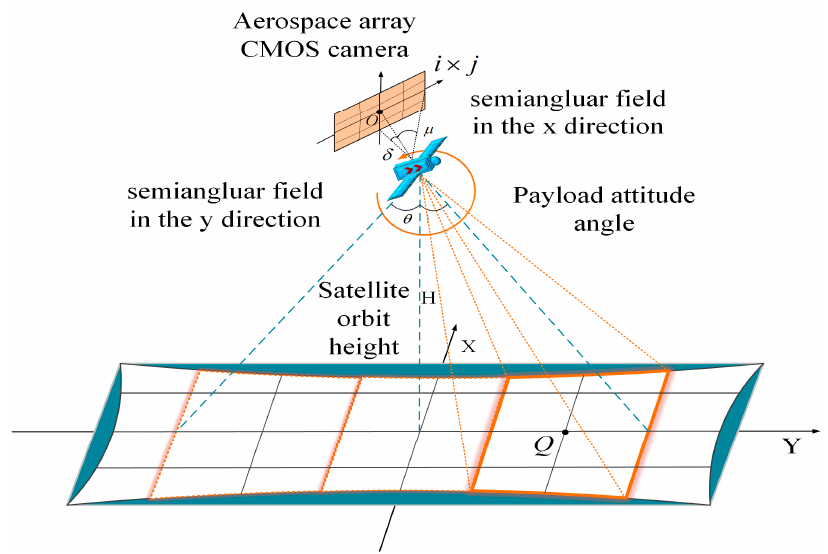
Figure 4. Schematic diagram of local dynamic frame-by-frame imaging. Firstly, the phase coordinate system is set, in which the center of the focal plane of the CMOS camera is the coordinate origin O . There are i × j imaging units on the phase surface (the number of imaging units in the X direction is i , and the number of imaging units in the Y direction is j ). Secondly, the object plane coordinate system is set, in which the center point of the ground imaging area is the coordinate origin Q . Then, the field angle δ and µ of any pixel point in the X direction and the Y direction on the camera focal plane can be expressed as: